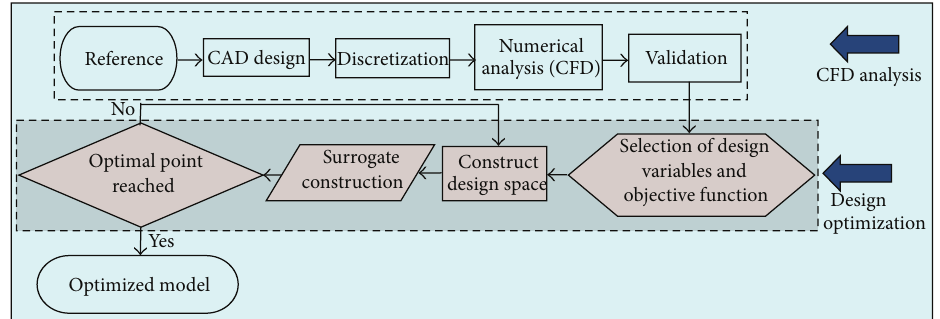
Figure 3: Optimization procedure.